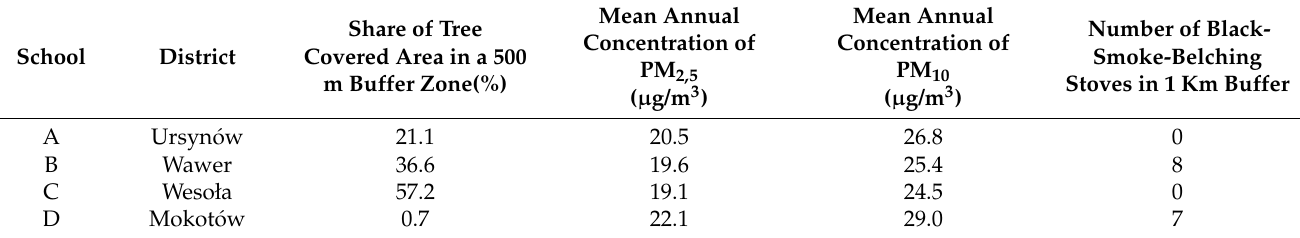
Table 1. Characteristics of investigated school locations and neighborhood in a 500 m buffer